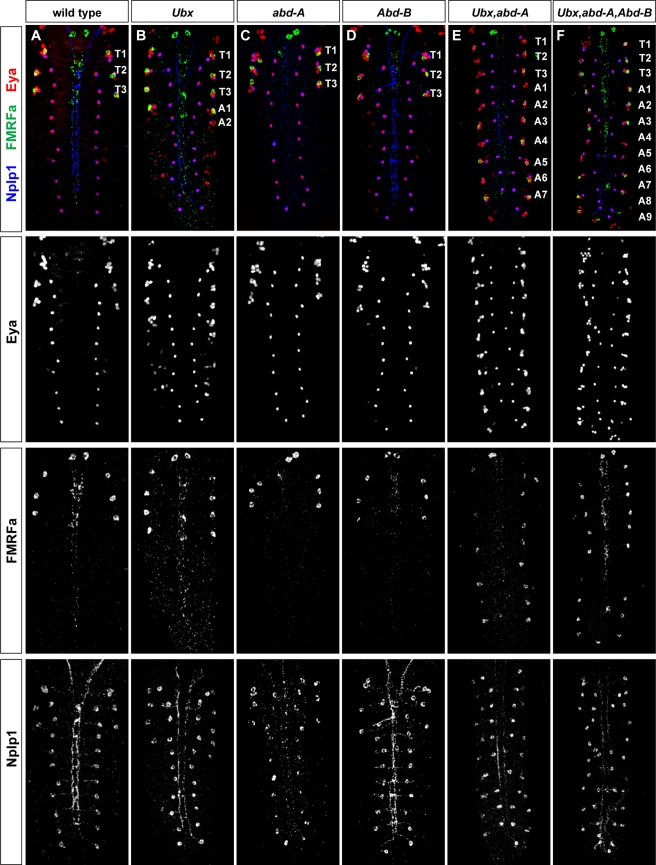
Homeotic transformations of the abdominal NB 5–6 lineage.(A–F) Analysis of Ap clusters, defined by expression of Eya, FMRFa, and Nplp1 in Bx-C single, double, and triple mutants, reveals the appearance of Ap clusters in abdominal segments. Due to genetic redundancy, in Ubx mutants (B), only A1 and partly A2 are transformed; in abd-A (C) and Abd-B (D), no segment is transformed; in Ubx, abd-A double mutants (E), A1–A8 are transformed, whereas in the triple mutant, all abdominal segments (A1–A9) are transformed (F). Stage 18 h AEL embryos. Genotypes: (A) w1118. (B) Ubx1/Ubx9.22. (C) abd-AMX1. (D) Abd-BM1/Abd-BM2. (E) Ubx109. (F) Dp(3;1)P68; ss1 Ubx1 abd-AD24 Abd-BD18.